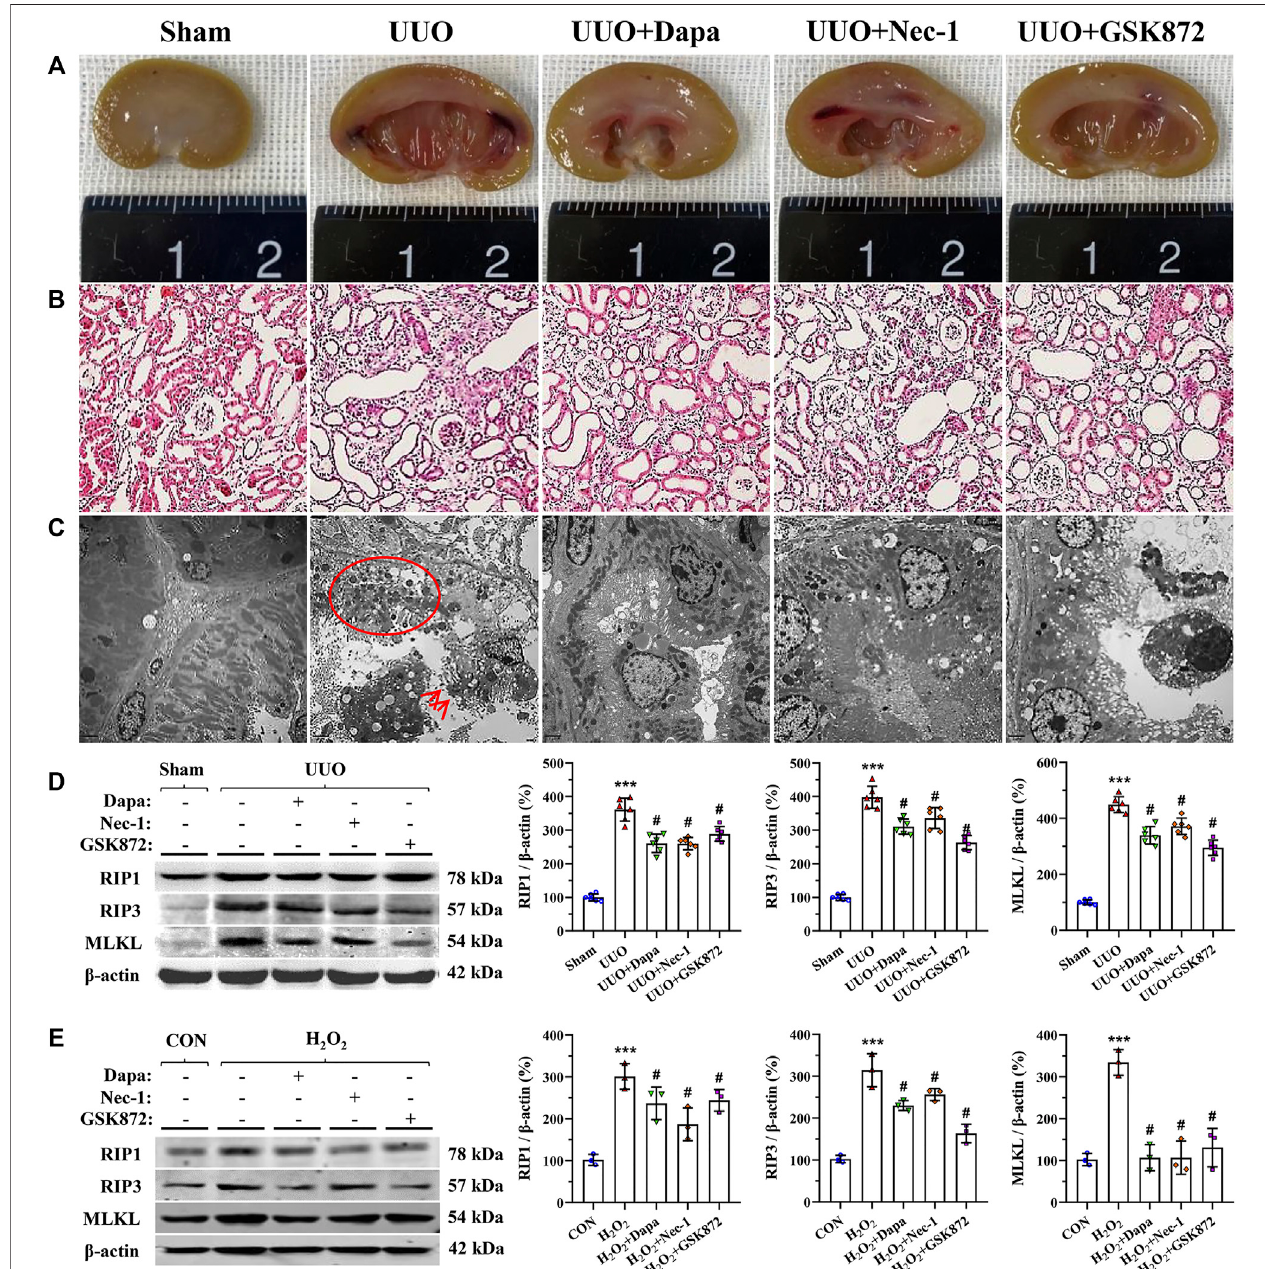
FIGURE 1 | Representative photomicrographs of gross fi nding (A) , HE staining (B) , transmission electron microscopy (C) , and immunoblotting analysis of RIP1-RIP3-MLKL protein in vivo (D) and in vitro (E) . UUO induces a crowd of necrosis within the tubular epithelium (circle) and abscission of microvilli in epithelial cells (arrows),whereas these are improved following administration ofDapa or RIP inhibitor. Dataare presentedas mean ± SEM ( in vivo , n (cid:2) 6; invitro , n (cid:2) 3) and analyzedby one-way ANOVA. *** p < 0.01 vs sham or control; # p < 0.05 vs UUO or H 2 O 2 .